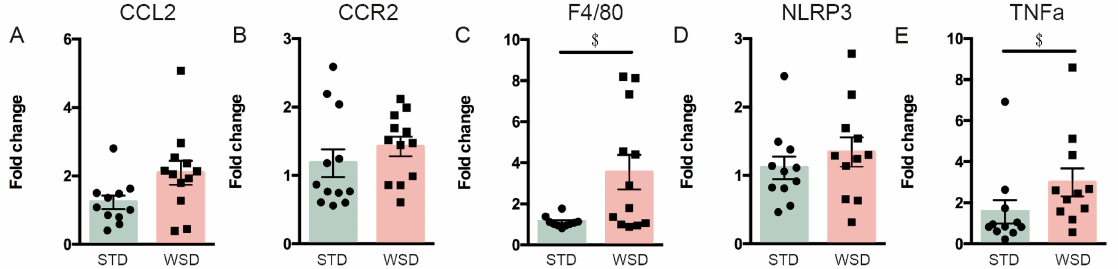
Figure 5. Effects of prolonged WSD exposure on adipose tissue inflammatory gene expression in CTL S-IMF animals at P230. ( A , B , D ) WSD exposure did not affect CCL2, CCR2 and NLRP3 expression levels. ( C , E ) WSD exposure increased F4/80 and TNF α expression in the adipose tissue. Data are presented as mean ± SEM; $ diet effect; p <